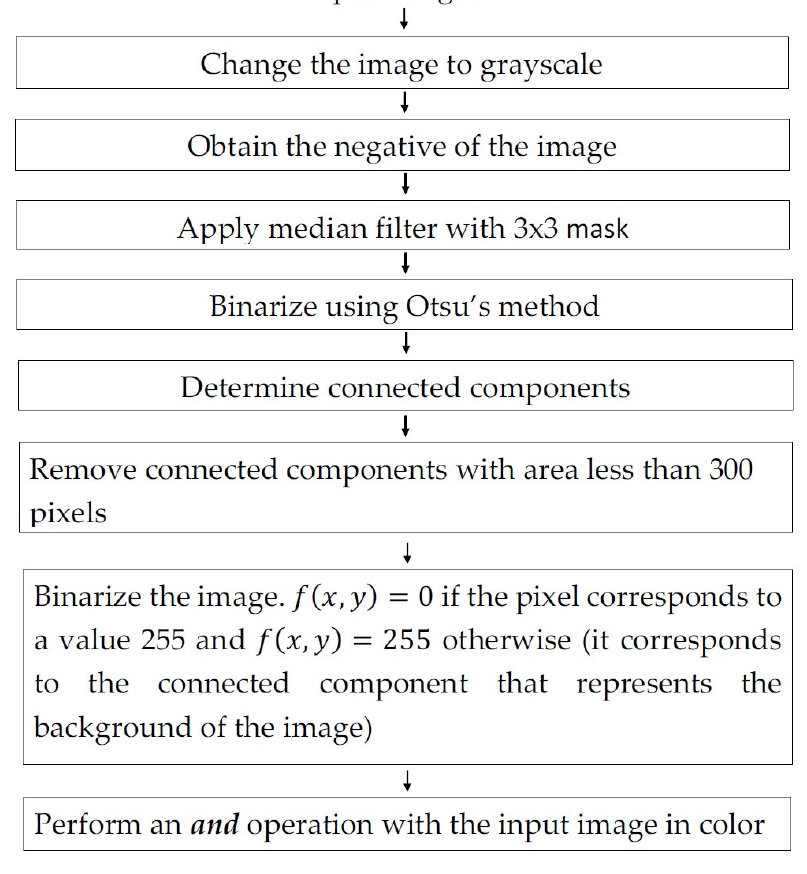
Figure 3. Steps to obtain the segmented image of the leaf. Figure 4 shows the steps applied to obtain the segmented image of the leaf to an image of the PlantVillages image set. Figure 4g shows the area of the sheet in white and the background in yellow that corresponds to the connected component with the largest area. Through the transformation given by f ( x , y ) = 0 if the pixel corresponds to a white pixel, and f ( x , y ) = 255 if the pixel corresponds to a background pixel, the binarized image is obtained as in Figure 4h. Finally, an and operation is performed with the color image to obtain the segmented image of the sheet as shown in Figure 4i.